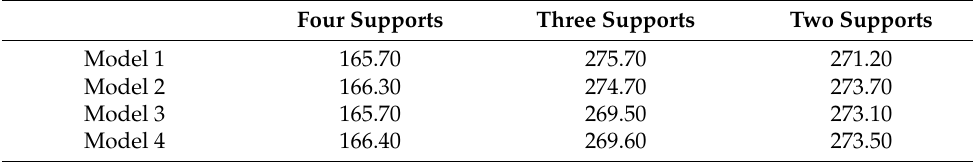
Table 2. The maximum Von–Mises stresses for different FE models (units in MPa). Four Supports Three